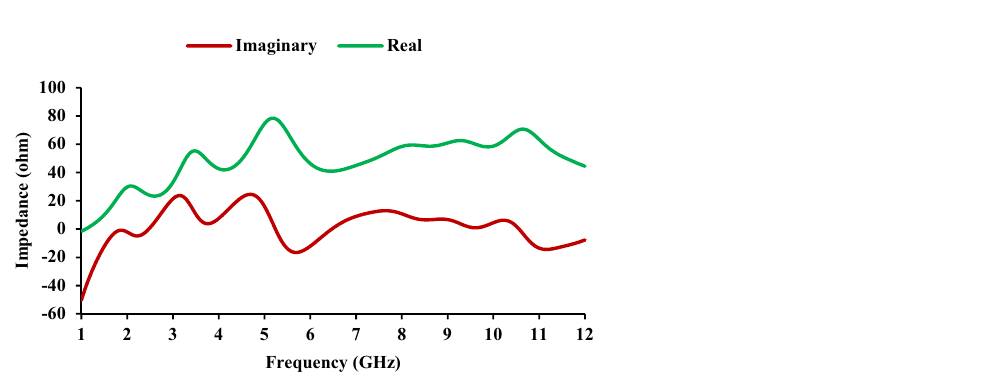
Figure 4. Measured and simulated reflection coefficients of the proposed antenna element.